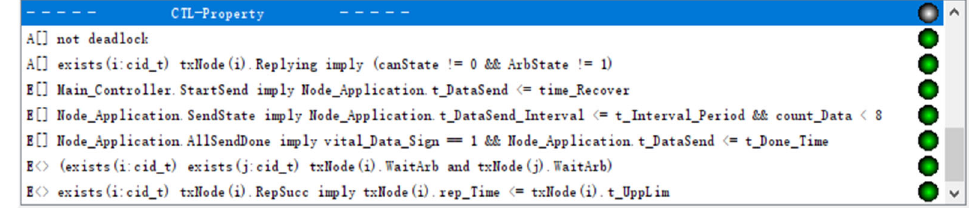
Figure 10. Verification results for the basic properties of the VACB model in UPPAAL.